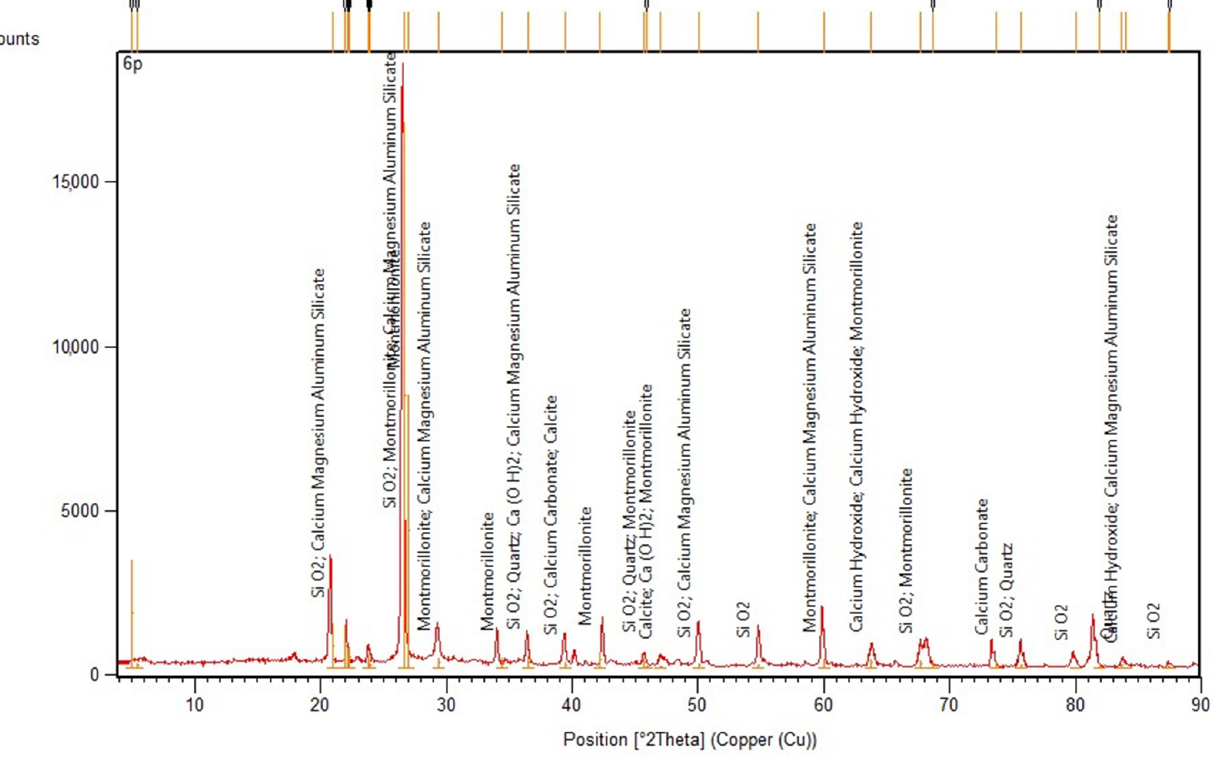
Figure 13. XRD pattern of the old concrete sample.